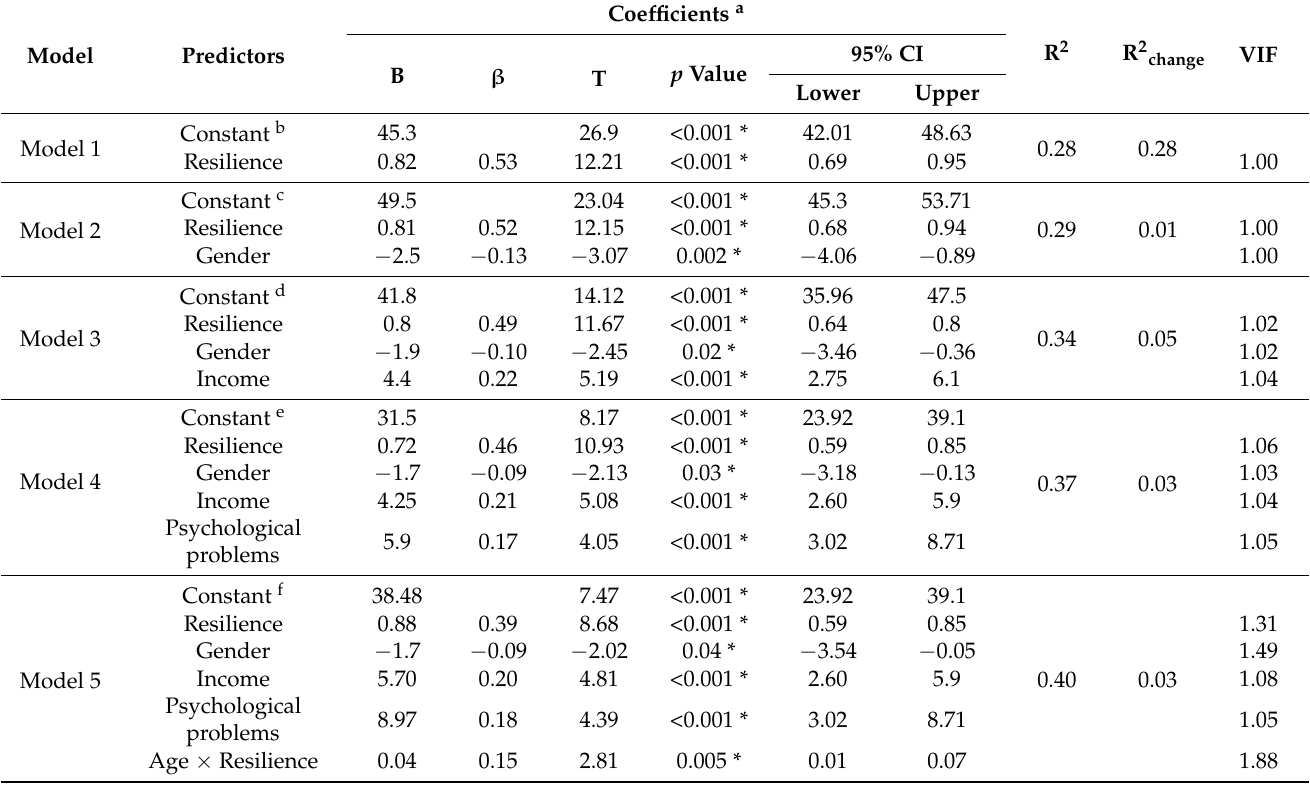
Table 7. Hierarchical multiple linear regression analysis for the total WHOQOL-BERF score as dependent variable.